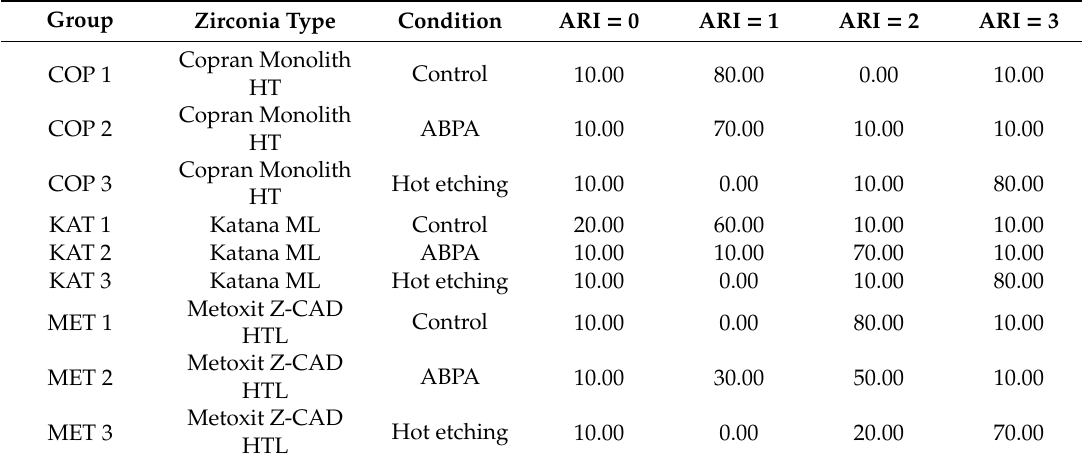
Table 4. Percentage frequencies of distribution of ARI scores.